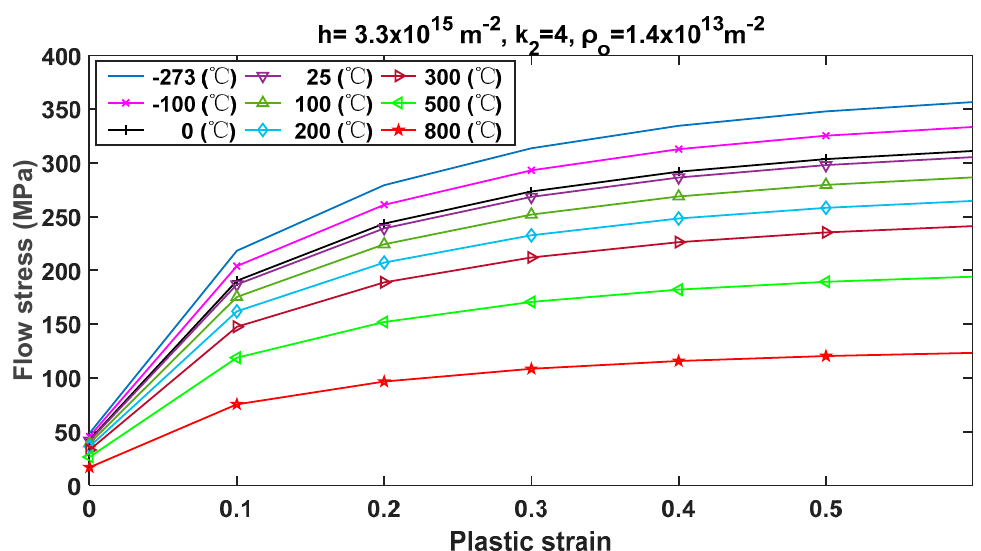
Figure 6. Flow stress curves at different temperatures and constant parameters h and k 2 and fixed initial dislocation density ( ρ o ).